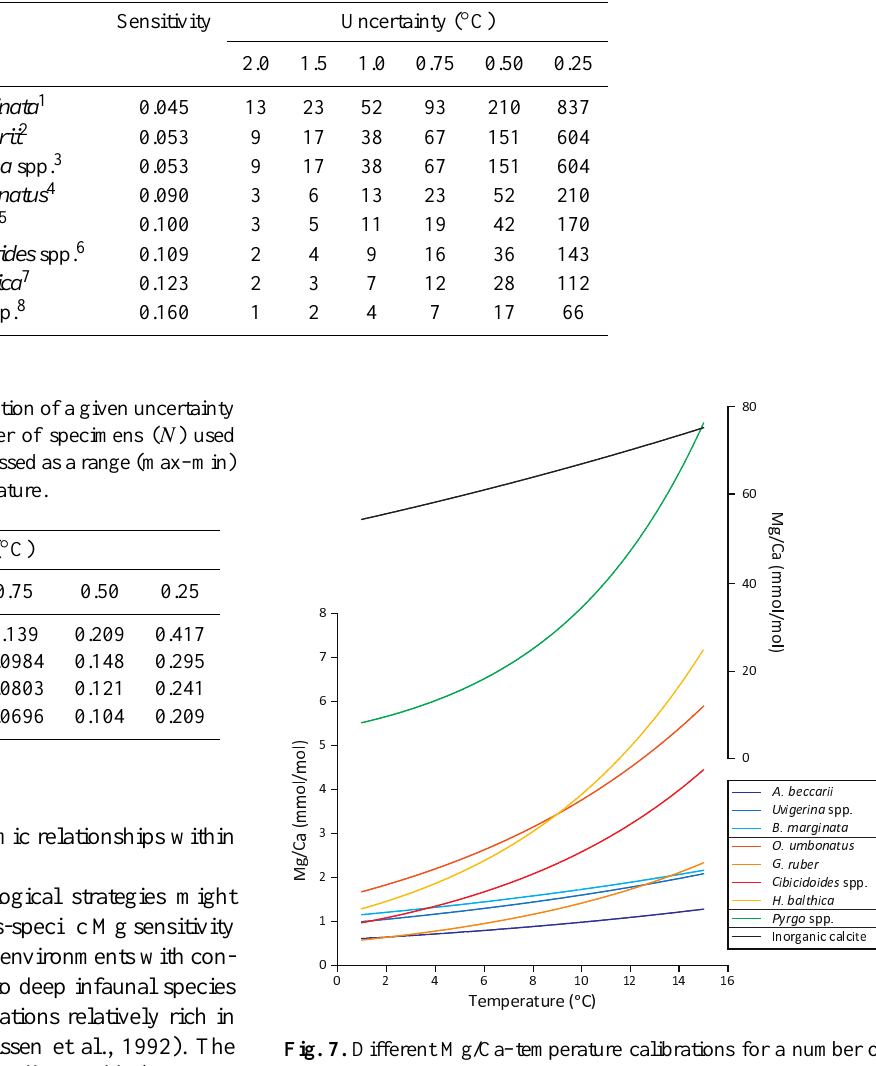
Fig. 7. Different Mg/Ca–temperature calibrations for a number of foraminiferal species (Table 5) and inorganic calcite (black line). Calibrations with a similar Mg sensitivity to temperature have a comparable steepness of the calibration slope. Note that the calibra- tion for Pyrgo spp. and inorganic calcite are plotted on a secondary y-axis. Mg/Ca values for these two calibrations are a magnitude of order larger compared to the other